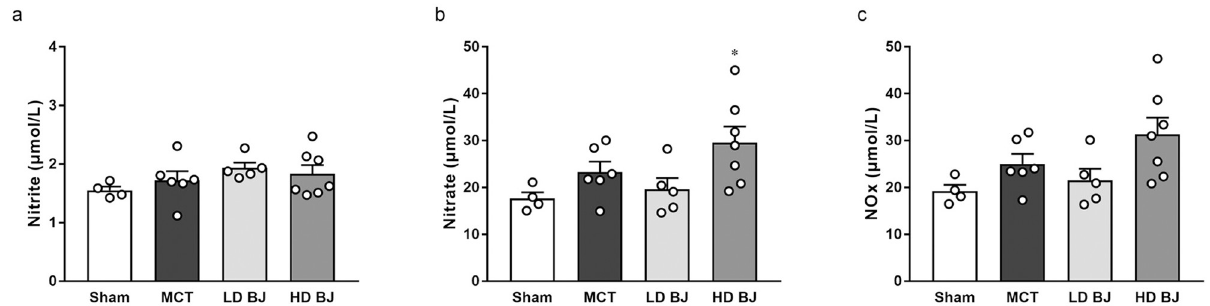
Fig 2. Effects of nitrate-rich BJ supplementation on plasma NO levels in MCT-injected rats. (a) nitrite. (b) nitrate. (c) NOx. Each point represents individual value; each column and bar represent the mean ± SEM values of 4–7 experiments. � p < 0.05, compared to the sham group. Statistical analysis was performed using one-way analysis of variance with Sidak post hoc test. Abbreviations: BJ, beetroot juice; HD, high-dose; LD, low-dose; MCT, monocrotaline; NOx, nitrite plus